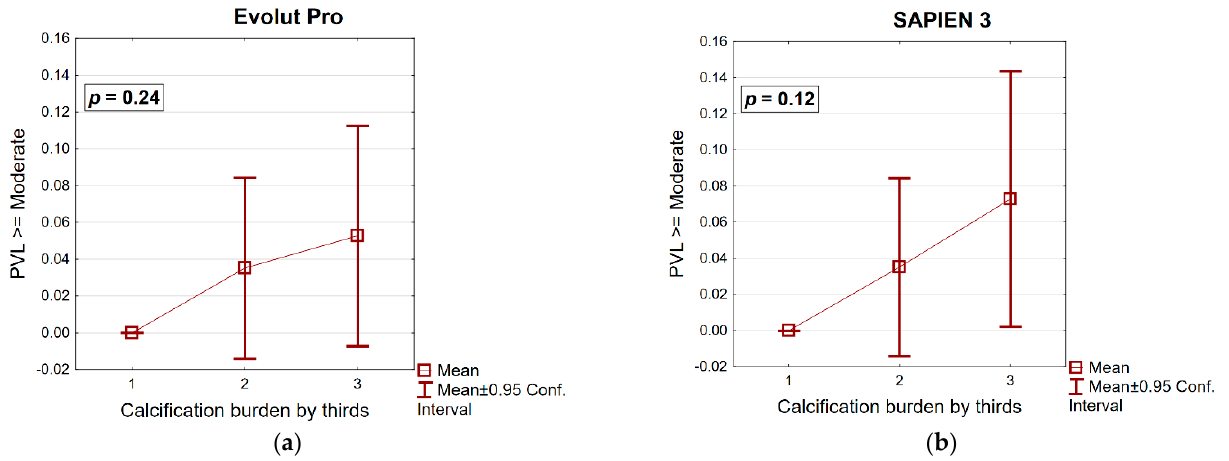
Figure 1. ( a ) Paravalvular leakage ≥ the medium in relationship to the calcification burden in patients that received an EPro THV. The total calcification burden of these patients was sorted by size and then divided into thirds. ( b ) Paravalvular leakage ≥ the medium in relationship to the calcification burden in patients that received an S3 THV. The calcification burden was grouped similarly.